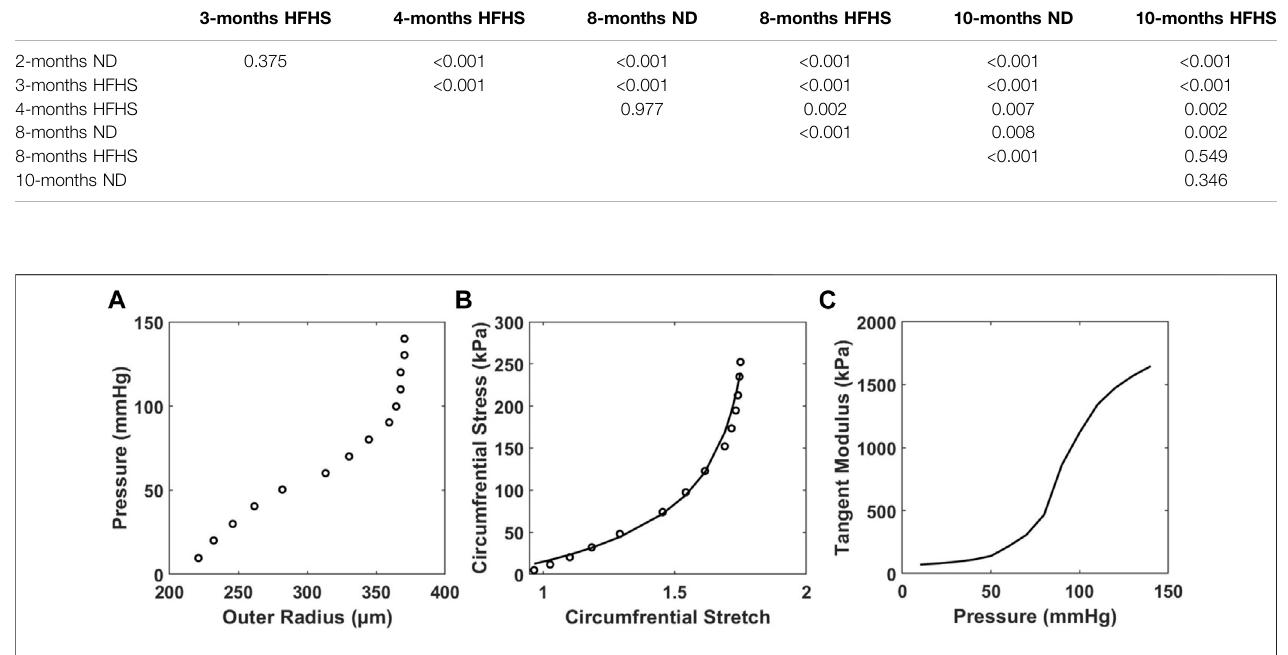
FIGURE5| Representativeresultsof (A) invitro pressure-outerradiuscurvesfrombiaxialextension-in fl ation test; (B) circumferentialstress-stretchcurves;and (C) tangent modulus vs. pressure of a carotid artery sample of a4-months ND mouse with model parameterc = 20.540 kPa, c 1 1 = 3.742 kPa; c 1 2 = 0.030; c 2 1 = 11.267kPa; c 2 2 = 0.043; c 3 , 4 1 = 0.008 kPa; c 3 , 4 2 = 1.373 kPa, and α = 46.352 ° (Gkousioudi et al.,